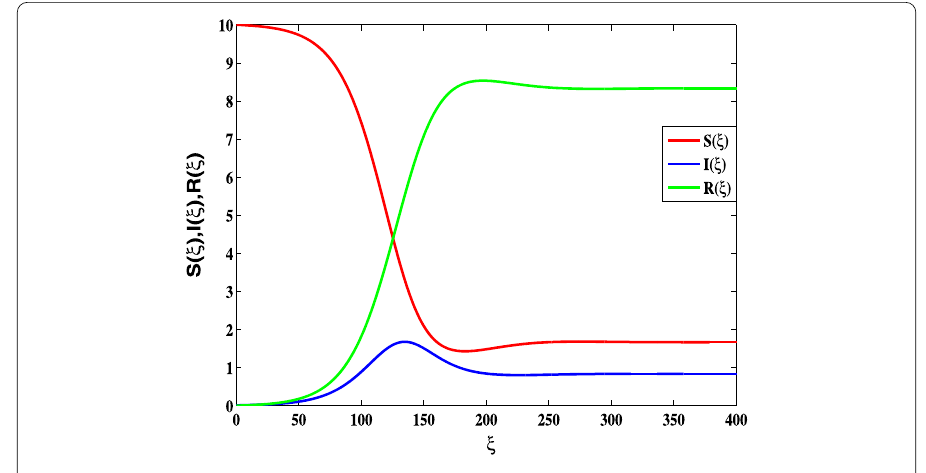
Figure 4 The traveling solution is observed in system (4), where the initial ( S (0), I (0), R (0)) = (10,0.01.0)